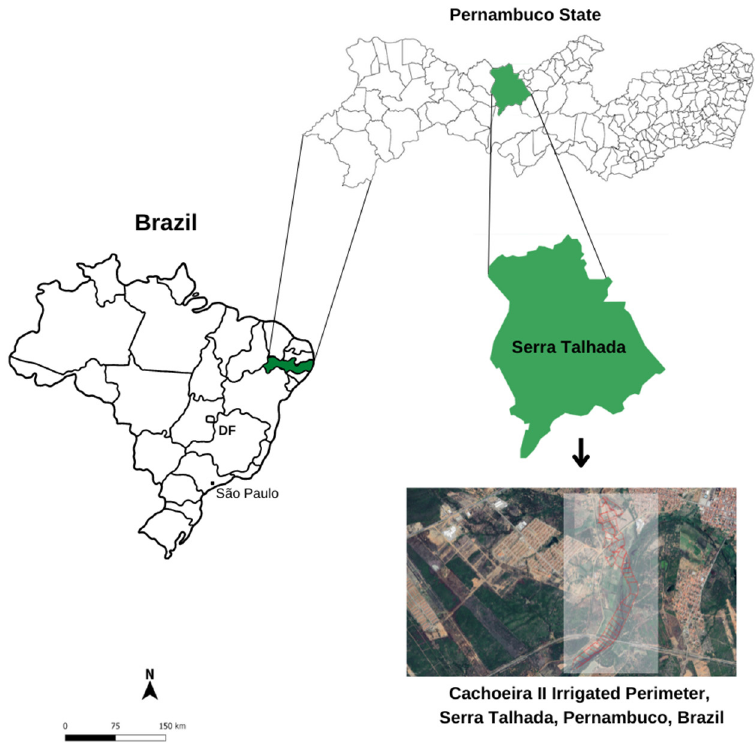
Figure 1. Study area location, Irrigated Perimeter Cachoeira II, Serra Talhada, State of Pernambuco, Brazil.